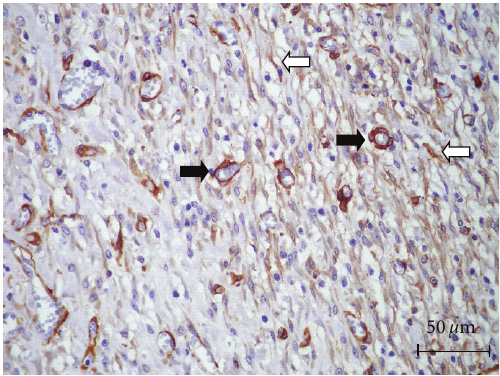
Figure 7: Pattern of immunohistochemical expression of α - SMA (UAL, 14 days). Positive cells scattered in the connective tissue, parallel arranged in relation to the collagen fibers (white arrows), were regarded as myofibroblasts. Positive cells disposed, surrounding the newly formed blood vessels (black arrows) were considered pericytes (Immunohistochemistry,